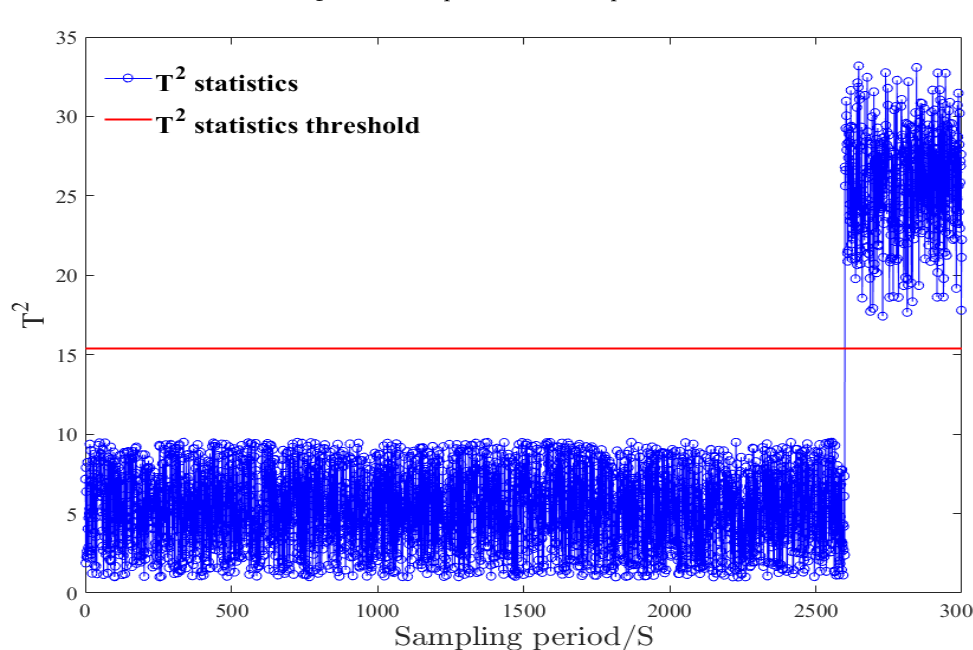
Figure 4. Value of the T 2 statistic under the condition of an LPC (low pressure compressor) fault.